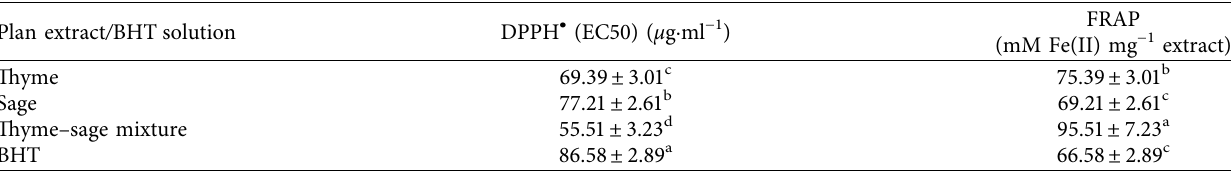
∗ Diferent letters in each group indicate signifcant diferences ( P <